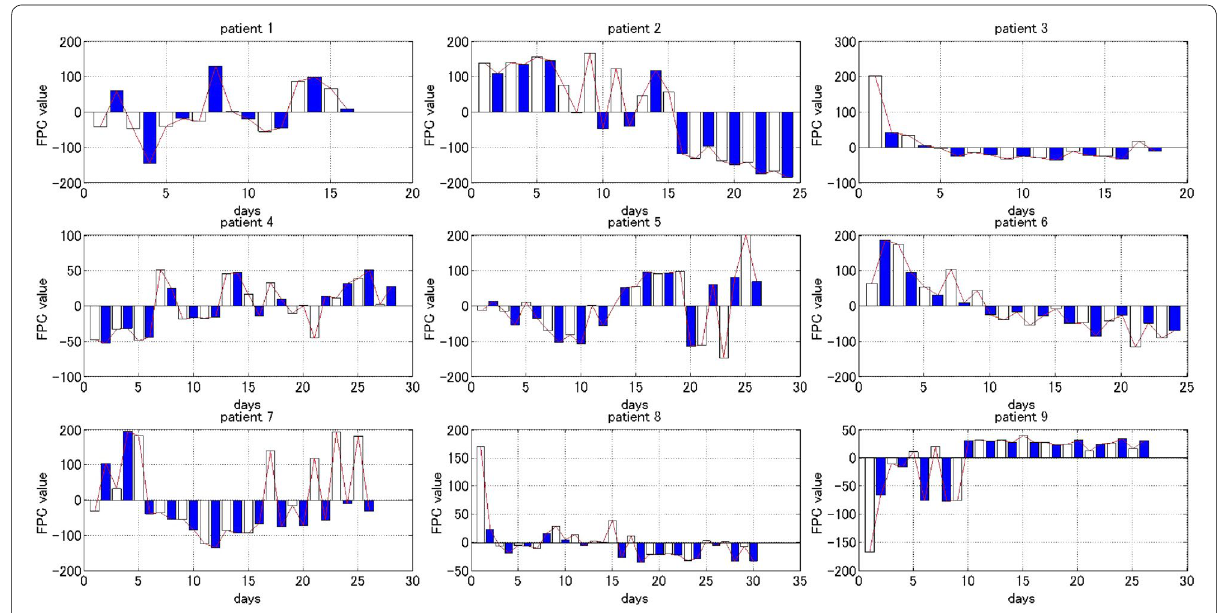
Fig. 4 The overall tendency and local variation of the